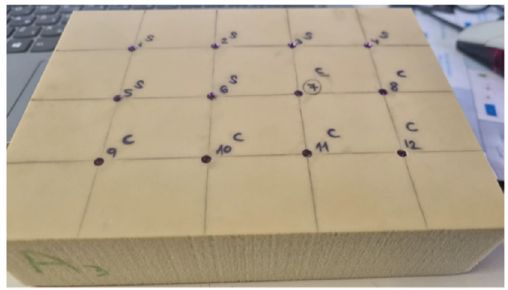
Figure 1. The experiment model of inserted implants in artificial bone block material made of synthetic polyurethane foam blocks.